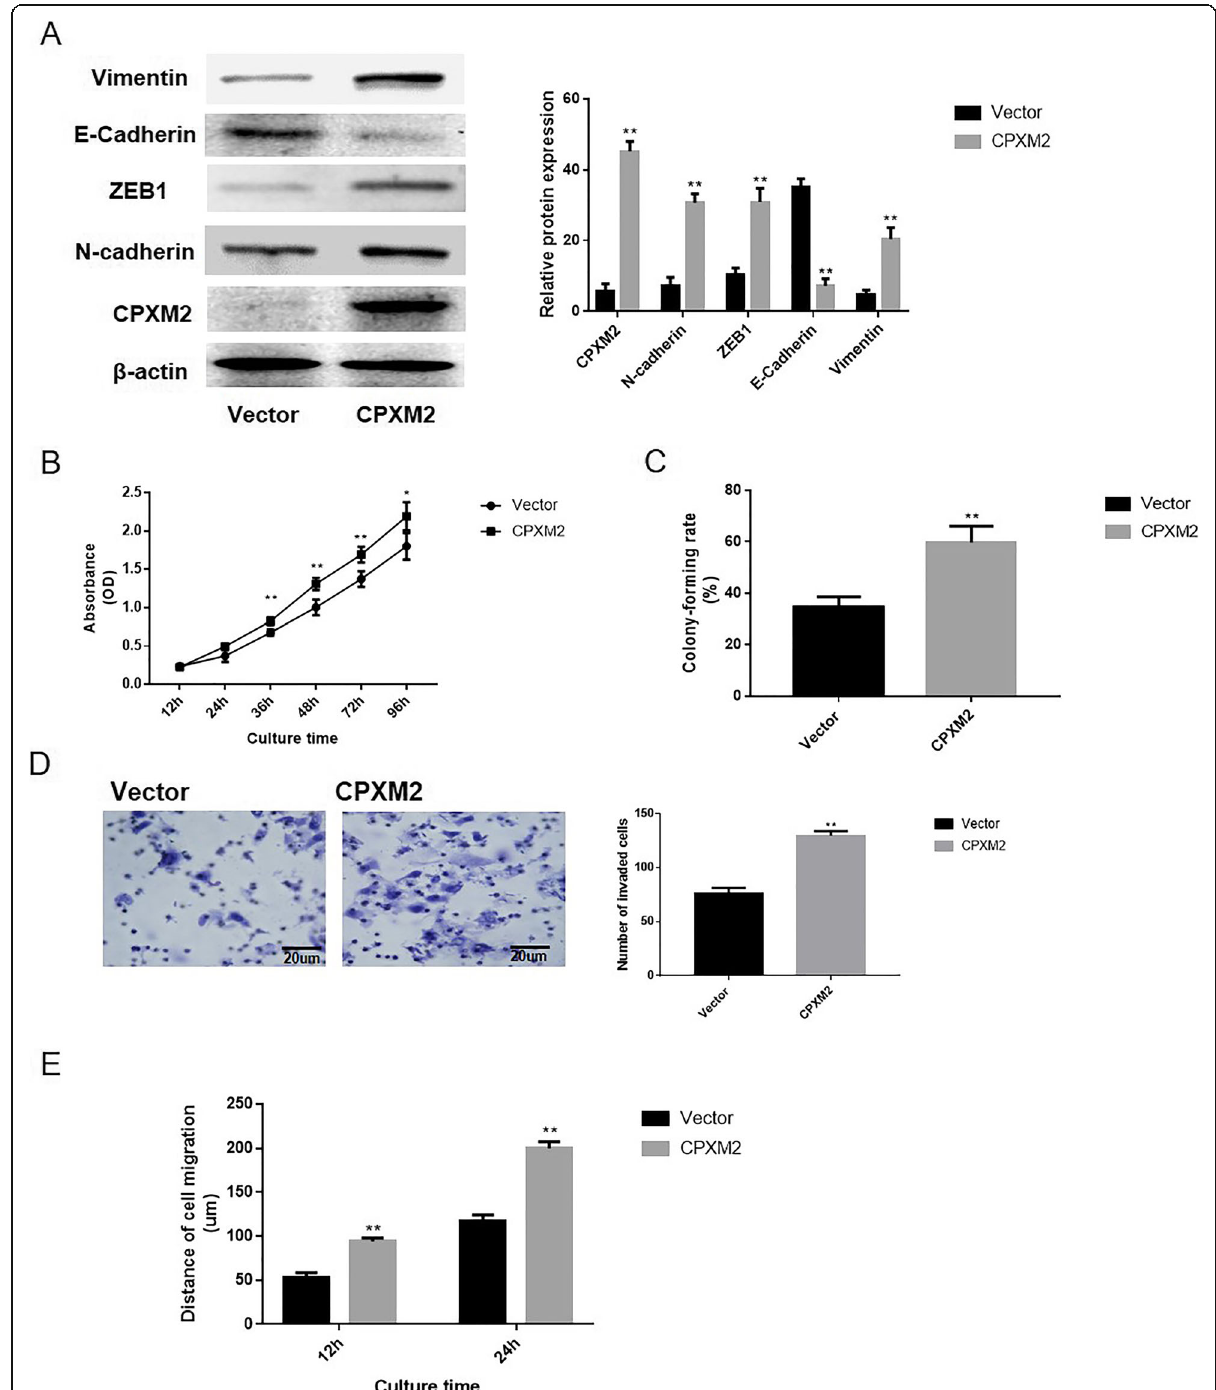
Fig. 3 Impact of CPXM2 on the proliferation and metastasis of osteosarcoma cells in vitro. a Western blotting to examine the EMT process in the hFOB.1.19 cell line and the corresponding statistical analysis of EMT process components. b Growth curves of hFOB.1.19 cells as determined using the Cell Counting kit-8. c The abilities of hFOB.1.19 cells to form colonies under 2D culture condition were determined through colony formation assay. d Matrigel invasion assay to examine the invasive ability of hFOB.1.19 cells in vitro. Scale bars, 20 μ m. e Wound-healing assay to detect the migration ability of hFOB.1.19 cells in vitro. ** P < 0.01 vs. the empty vector groups. CPXM2, Carboxypeptidase X, M14 family member 2; EMT, epithelial mesenchymal transition; OD, optical